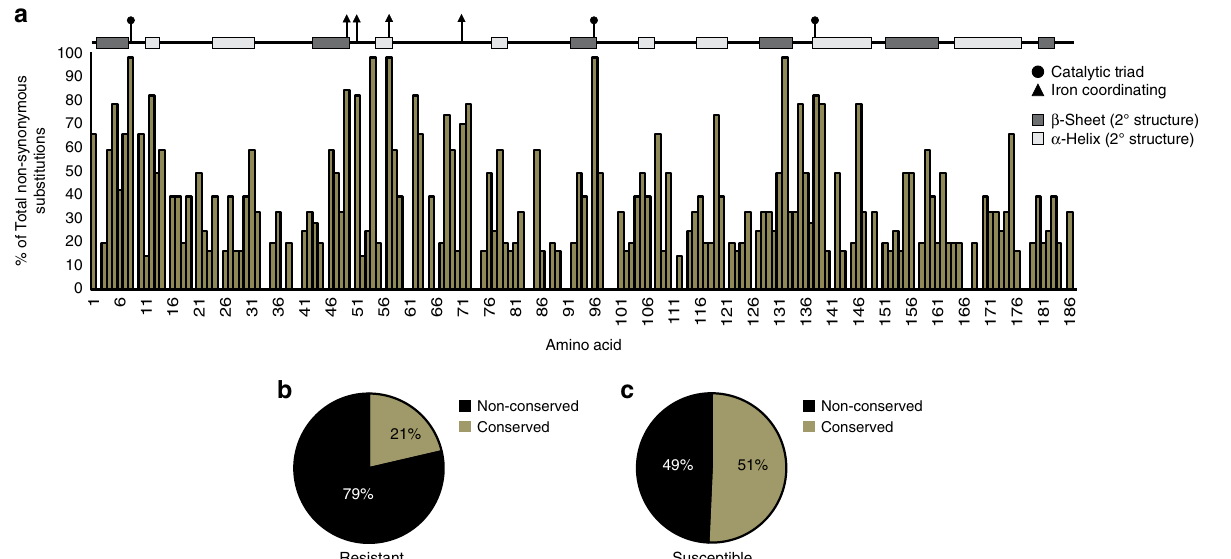
Fig. 4 Pyrazinamide resistant amino acid substitutions occur throughout PncA and are enriched for non-conserved amino acid substitutions. a The proportion (%) of non-synonymous amino acid substitutions represented in the pncA library that were pyrazinamide resistant at each PncA amino acid. Amino acids corresponding to the catalytic triad are marked with a circle . Amino acids responsible for iron coordination are marked with a triangle . b Percentage (%) of non-conserved ( black ) and conserved ( brown ) pyrazinamide resistant amino acid substitutions. c Percentage (%) of non-conserved ( black ) and conserved ( brown ) pyrazinamide susceptible amino acid